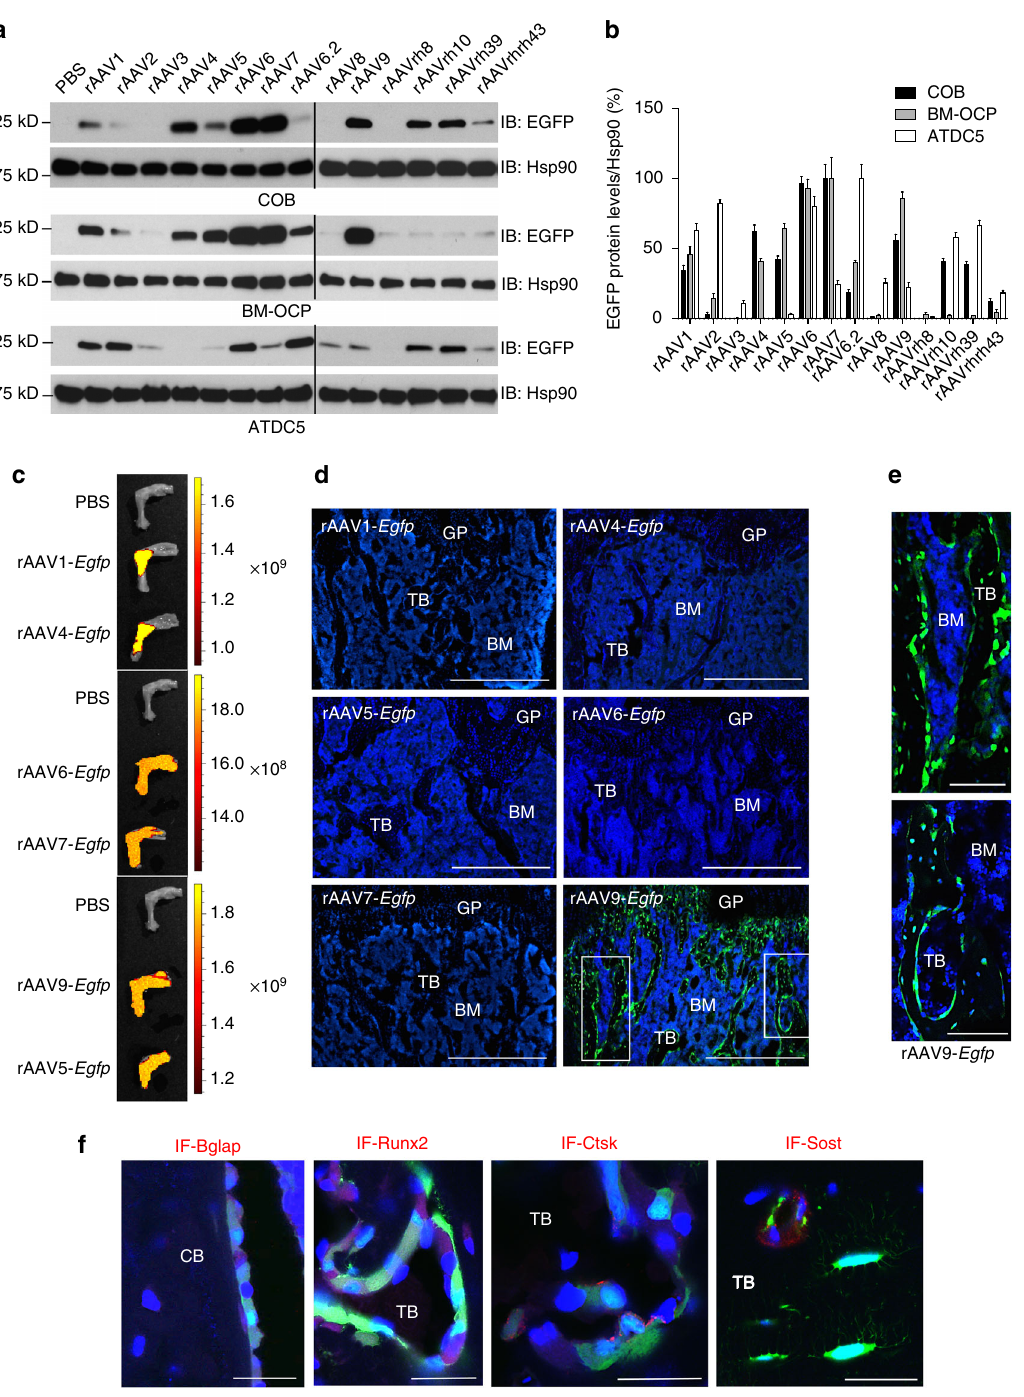
Fig. 1 Identi fi cation of rAAV vectors that transduce bone cells in vitro and in vivo. a , b Calvarial osteoblasts (COB), bone marrow-derived osteoclast precursors (BM-OCP), or chondrogenic cells (ATDC5), were treated with PBS or 14 different AAV capsids packaged with the same CB-Egfp transgene. After 2 days, EGFP expression was assessed by immunoblotting with an anti-GFP antibody ( a ). The anti-Hsp90 antibody was used as a loading control. b Immunoblot quanti fi cation of EGFP protein was measured as a percentage of endogenous Hsp90 protein level by ImageJ software. c – f A single dose of 1 × 10 11 genome copies of rAAV was intraarticularly (i.a.) injected into the knee joints of 2-month-old male mice, and EGFP expression in the hindlimb was monitored by IVIS-100 optical imaging 2 weeks post injection ( c ). Femurs were cryosectioned and EGFP expression was assessed by fl uorescence microscopy ( d ). e High-magni fi cation images of EGFP-expressing cells in the femur. Cryo-sectioned femurs were also immunostained for Bglap, Runx2, Ctsk, and Sost to identify osteoblasts, mature osteoclasts, and osteocytes, respectively ( f ). TB, trabecular bone; BM, bone marrow; GP, growth plate; CB, cortical bone. Scale bars: d 500 μ m; e 100 μ m; f 25 μ